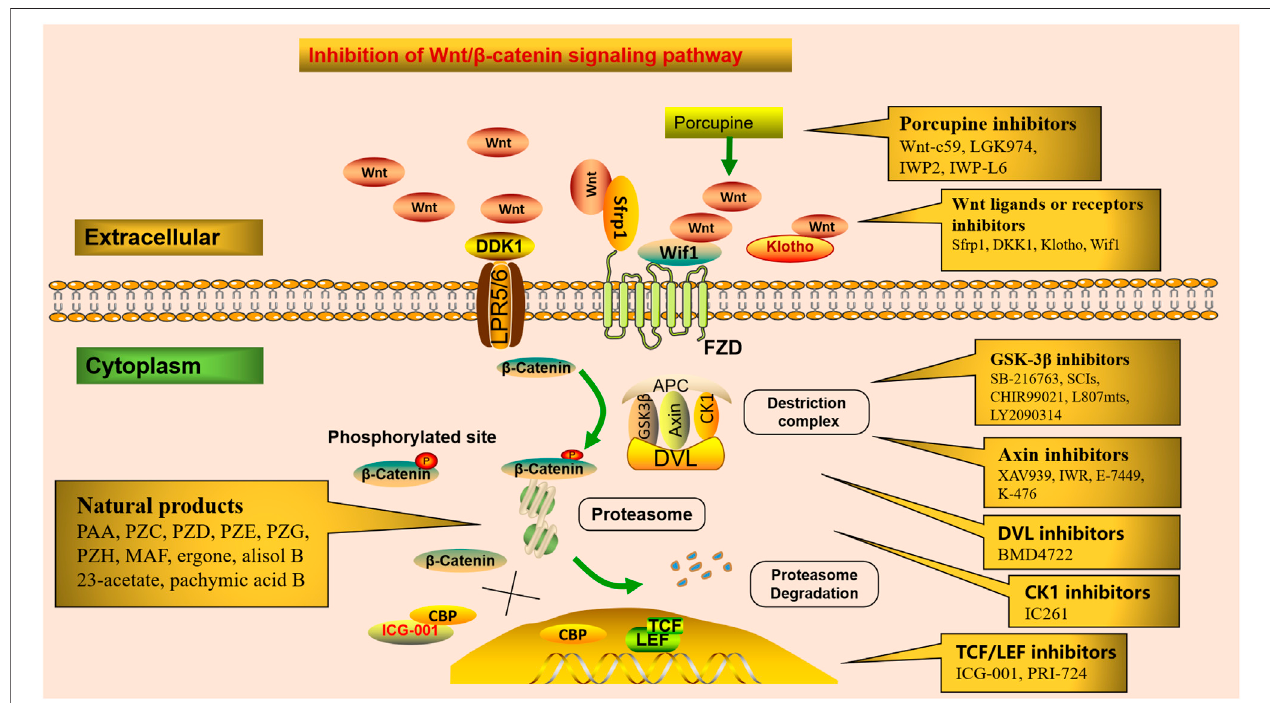
FIGURE2| PotentialtherapeutictargetsintheWnt/ β -cateninsignaling.NumeroussmallmoleculesinhibitWnt/ β -cateninsignalingatdifferentstepsofthepathway. Porcupine inhibitors prevent Wnt ligands secretion. Receptor or co-receptor inhibitors prevent the receptor actions of Wnt ligands. Inhibitors of GSK3 β , axin, DVL, and CK1 interferewithWnt/ β -catenindownstreamsignaling.InhibitorsofTCF/LEFsuppressWnt/ β -catenin-dependent genetranscription.Severalnaturalproducts alleviate renal fi brosis by regulating the Wnt/ β -catenin signaling pathway.